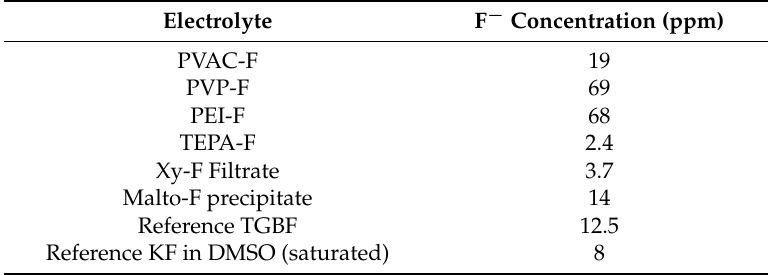
Table 2. Fluoride content and conductivity of the different compounds.